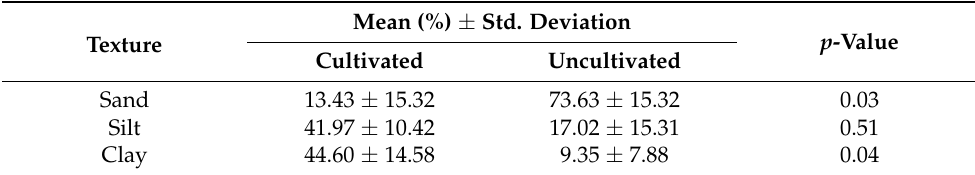
Table 2. Soil texture for cultivated and uncultivated wetland